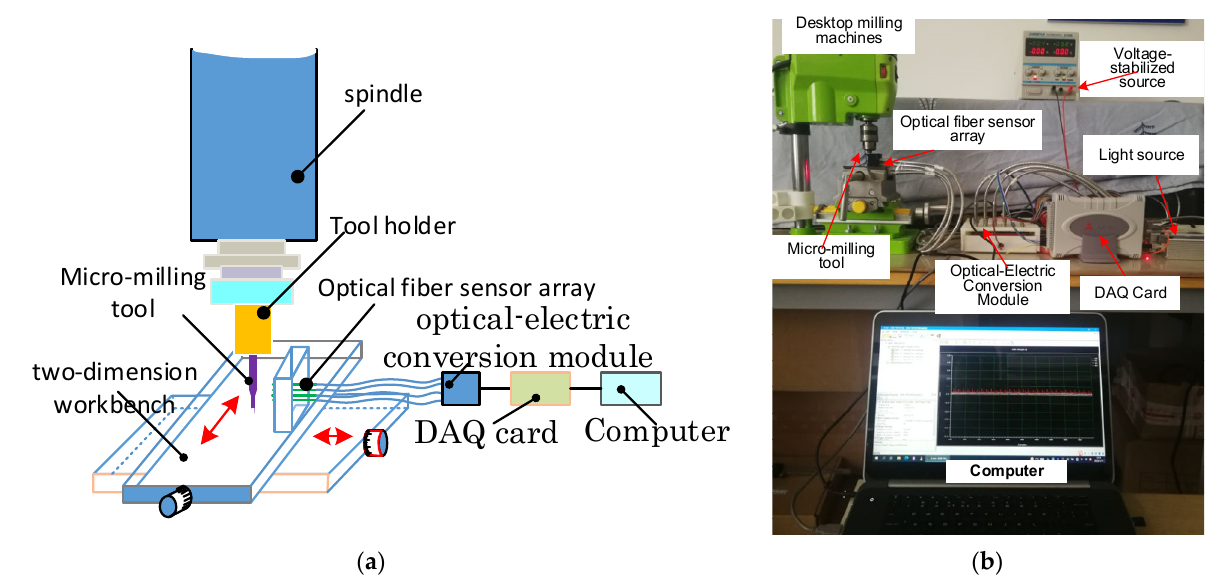
Figure 10. Micro-milling tool vibration measurement experimental system set up. ( a ) Schematic diagram of the set-up and ( b ) the actual set up for micro-milling tool.